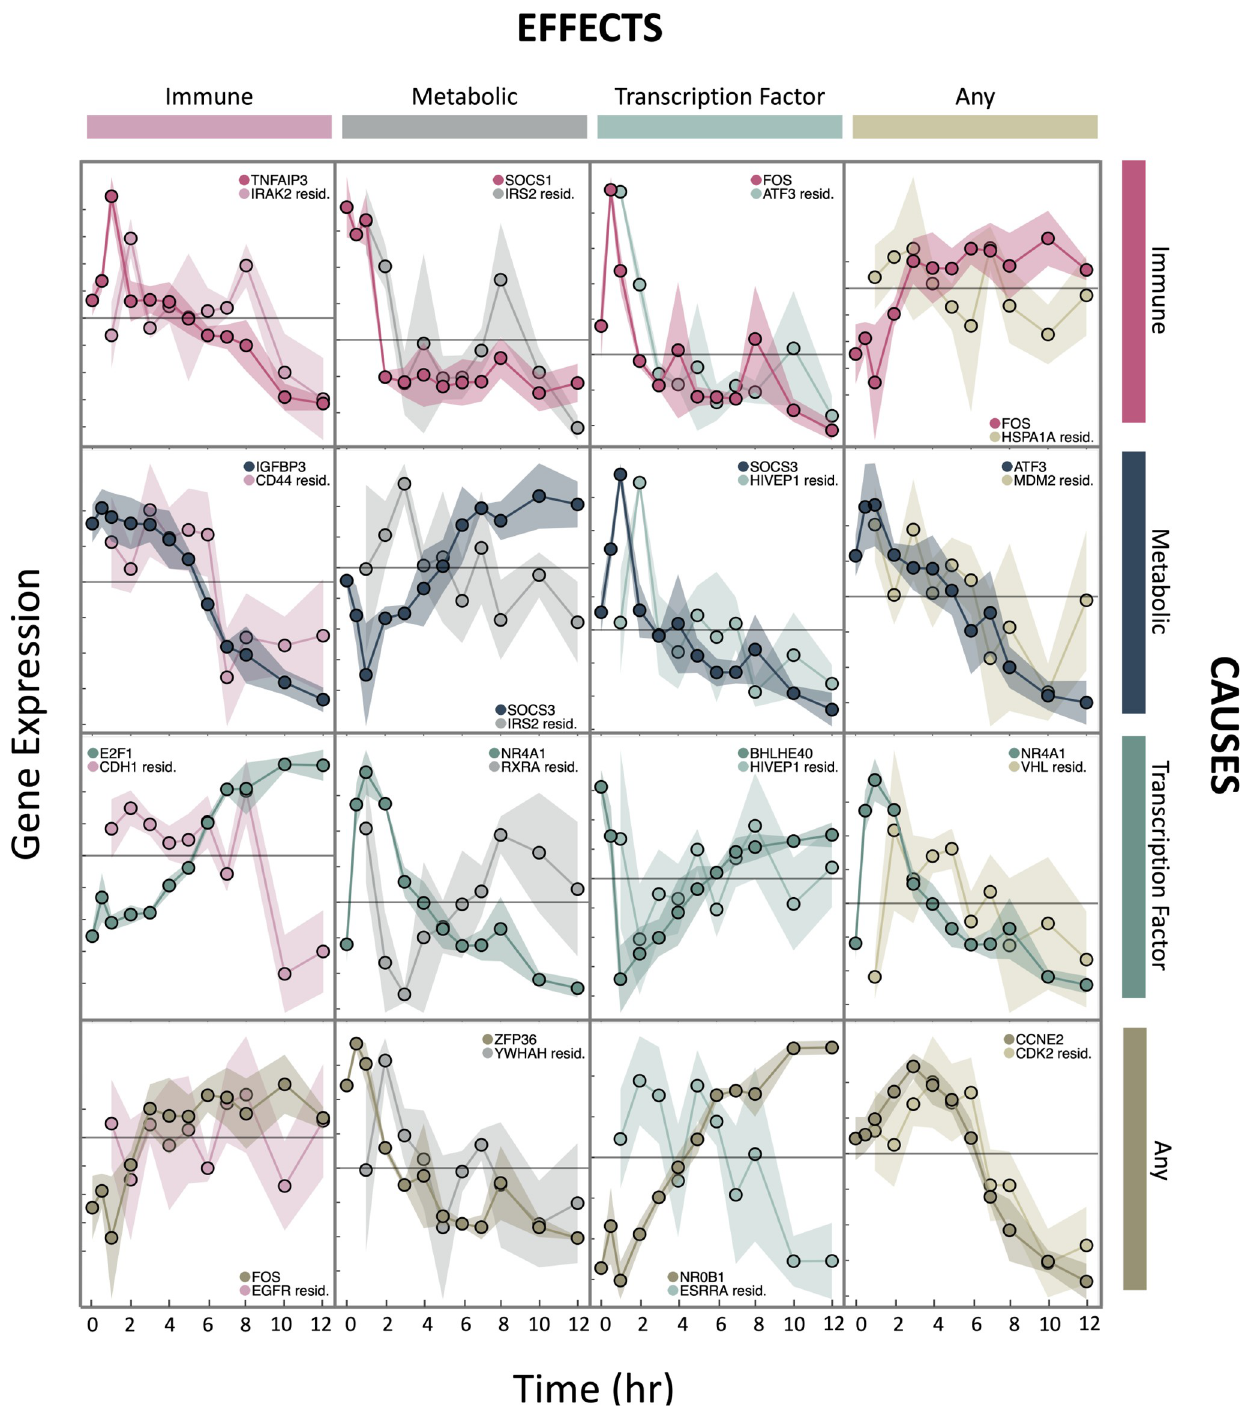
Fig 5. Time-series profiles of experimentally validated causal interactions across gene classes. For each gene pair, their profiles were from either the original exposure data set or the unperturbed data set. The effects of all covariates beside the causal gene were controlled in the effect gene values to show the conditional Granger-causal relationship. Colors encode gene classes: pink shows immune genes, dark blue/gray shows metabolic genes, teal shows TFs, and brown/tan shows other genes. Darker colors show causal genes and lighter colors show effect genes. The grey line marks zero-centered expression. Each y- axis tick indicates 0.1 unit-variance standardized ln(TPM). See also S7 Table and S2 Fig.